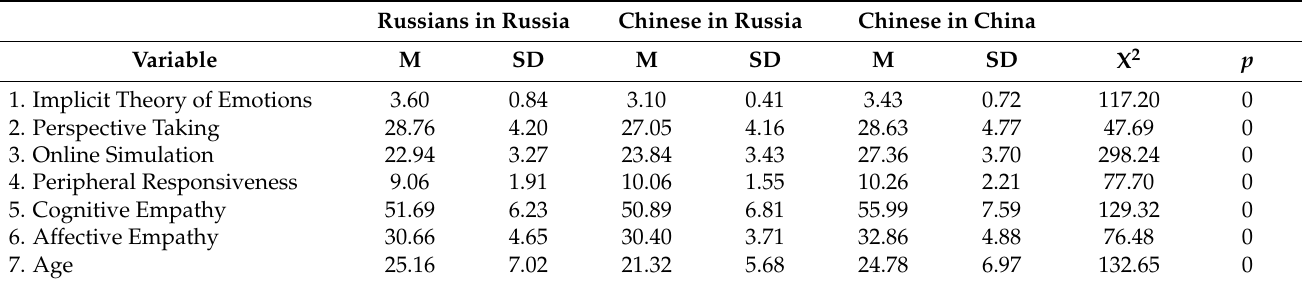
Table 1. Descriptive statistics for study